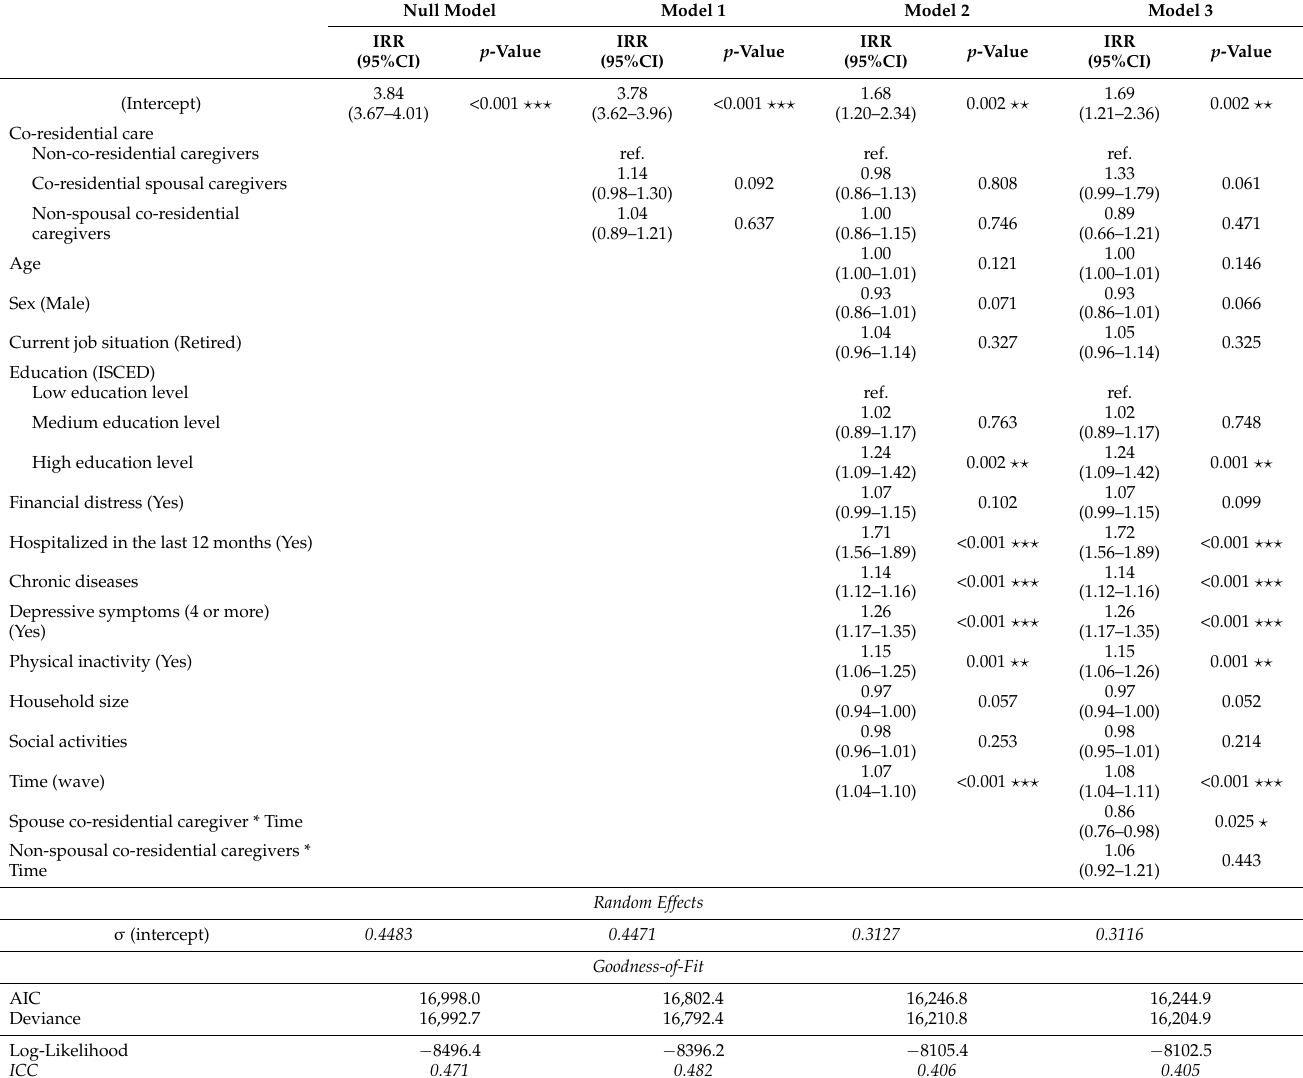
Table 2. Longitudinal association between co-residential care provision and healthcare use among the Portuguese population aged 50 and